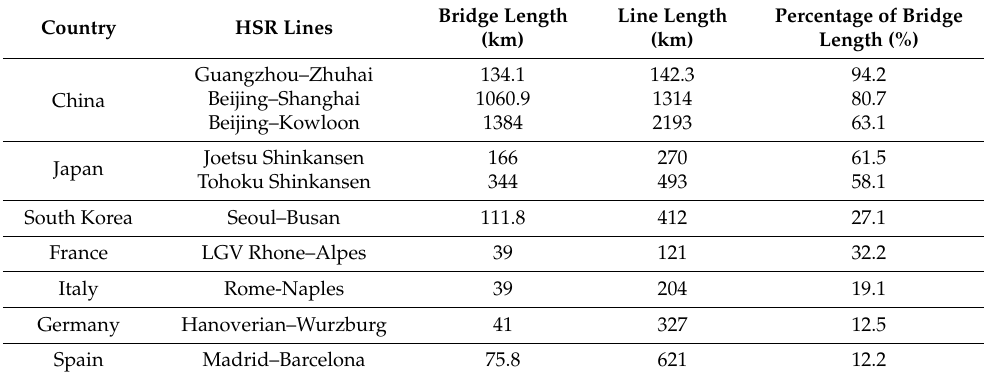
Table 2. HSR bridge length percentile in various countries. Adapted from